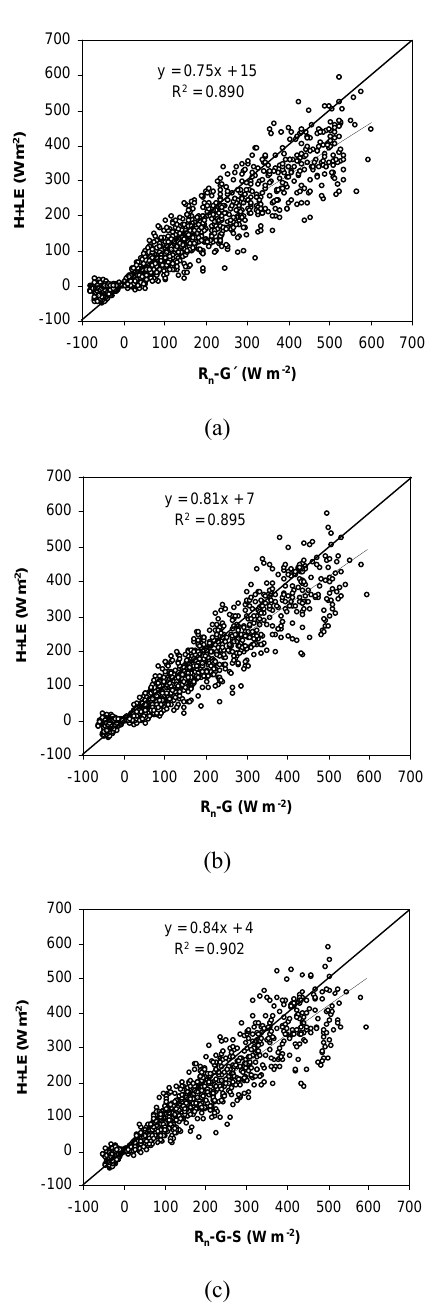
Fig. 1. Relationships between half-hourly data turbulent heat flux H+LE and available energy: (a) R n -G’, (b) R n -G, and (c) R n -G-S.